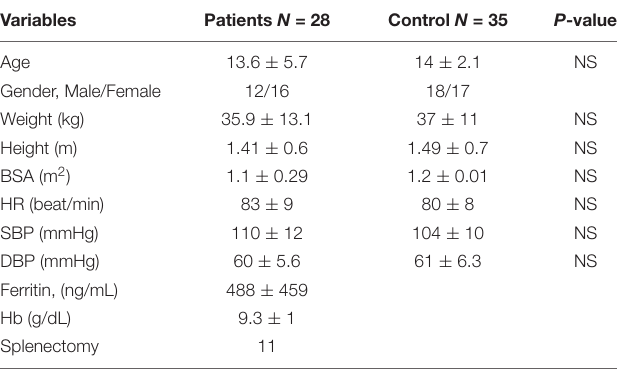
TABLE 1 | Demographic and clinical characteristics of patients and control subjects*.